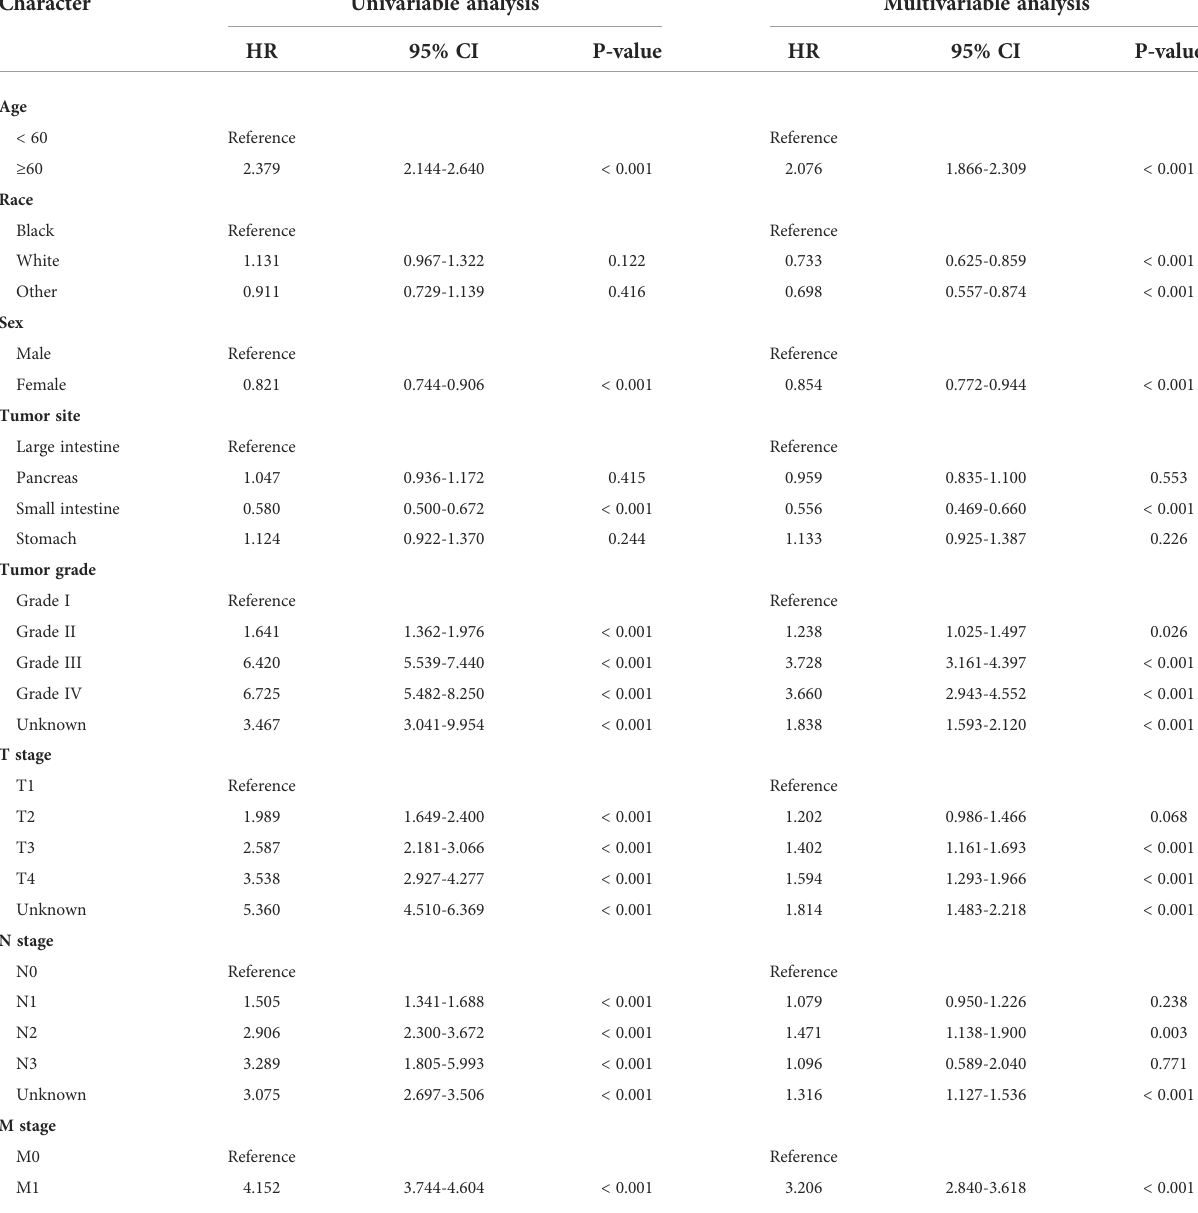
TABLE 2 Univariate and multivariate analysis of overall survival in the train